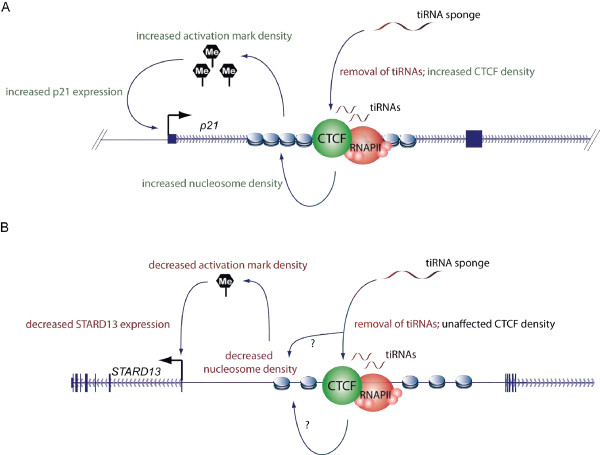
A schematic representation of transcription initiation (ti)RNA sponge effects on the p21 (cyclin-dependent kinase inhibitor 1A gene, also known as CDKN1A) and StAR-related lipid transfer domain containing 13 (STARD13) loci. (a) The p21 CCCTC-binding factor (CTCF) proximal (cp)-tiRNA sponge removes tiRNAs from the system, which in turn facilitates increased CTCF binding and, consistent with the literature, increased nucleosome ordering and density. CTCF-adjacent nucleosomes are known to be enriched for the H3K4 trimethylation (H3K4me3) transcription activation mark. Here we speculate that the increased density of this mark may drive the increased p21 expression observed in the presence of the cp-tiRNA sponge. (b) We observed little effect of the STARD13 sponge on CTCF density, but our results indicate that the sponge nonetheless induces reduced nucleosome density and STARD13 expression. Here we propose that reduced levels or concentrations of H3K4me3 marks due to the decrease in nucleosome density may modulate STARD13 expression. (a, b) Black, green and red text indicates no change, increased levels or decreased levels, respectively.